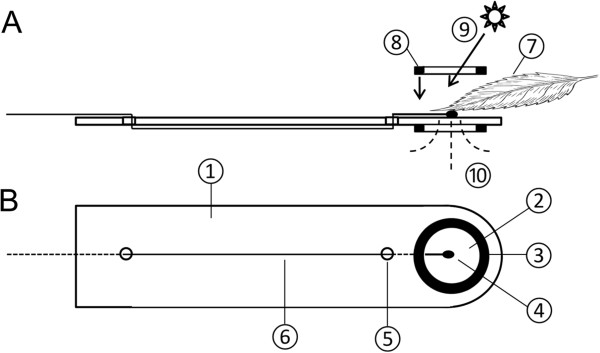
Leaf clamp for fast attachment of a thermocouple sensor to the leaf surface. A. side view, B. bottom view. The clamp consists of an elastic and thin PVC - strip (1) with an opening (2) that is surrounded by a weak, glued - on miniature ring magnet (3). Inside the opening a thermocouple sensor is placed. Two small holes in the strip (5) act as a strain relief for the thermocouple wire (6). With a second ring magnet (8) the sensor can easily be fixed to the bottom side of the leaf (7). The inner diameter of the magnets (6 mm) ensures unimpeded solar irradiation (9) and leaf transpiration (10). The leaf clamp is particularly suitable for use in wet or humid environments as heat exposure chambers and microclimate stations.